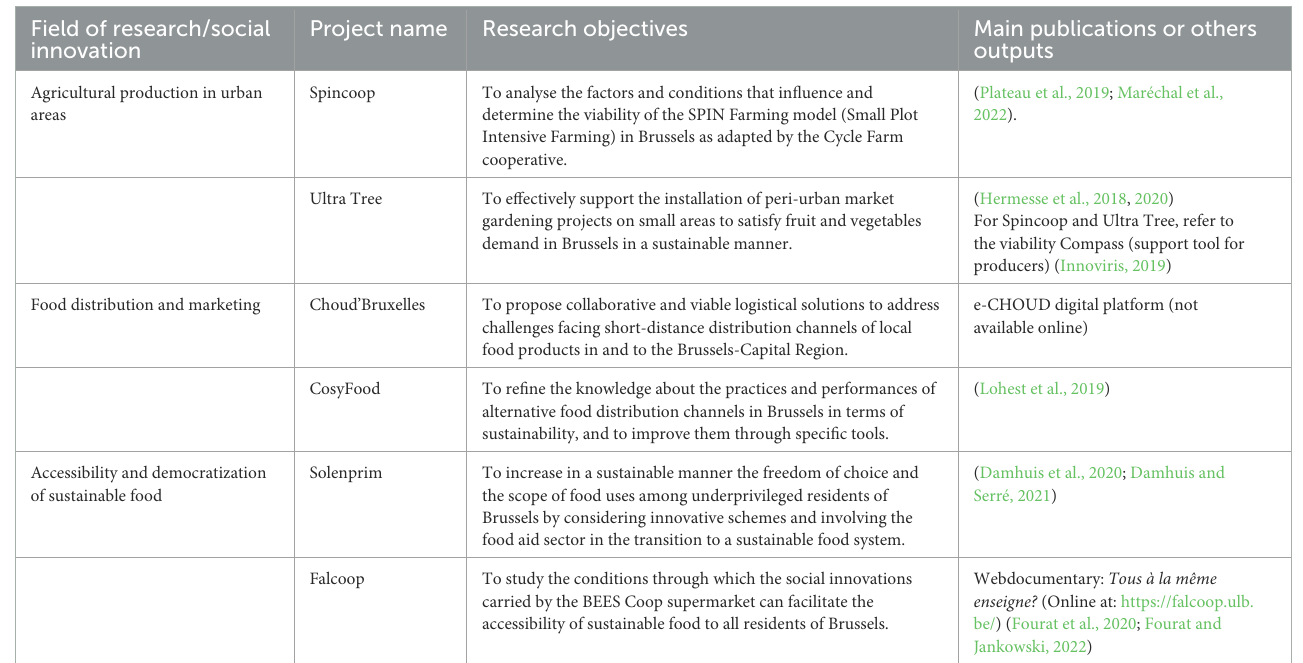
TABLE 1 Characteristics of the six co-create